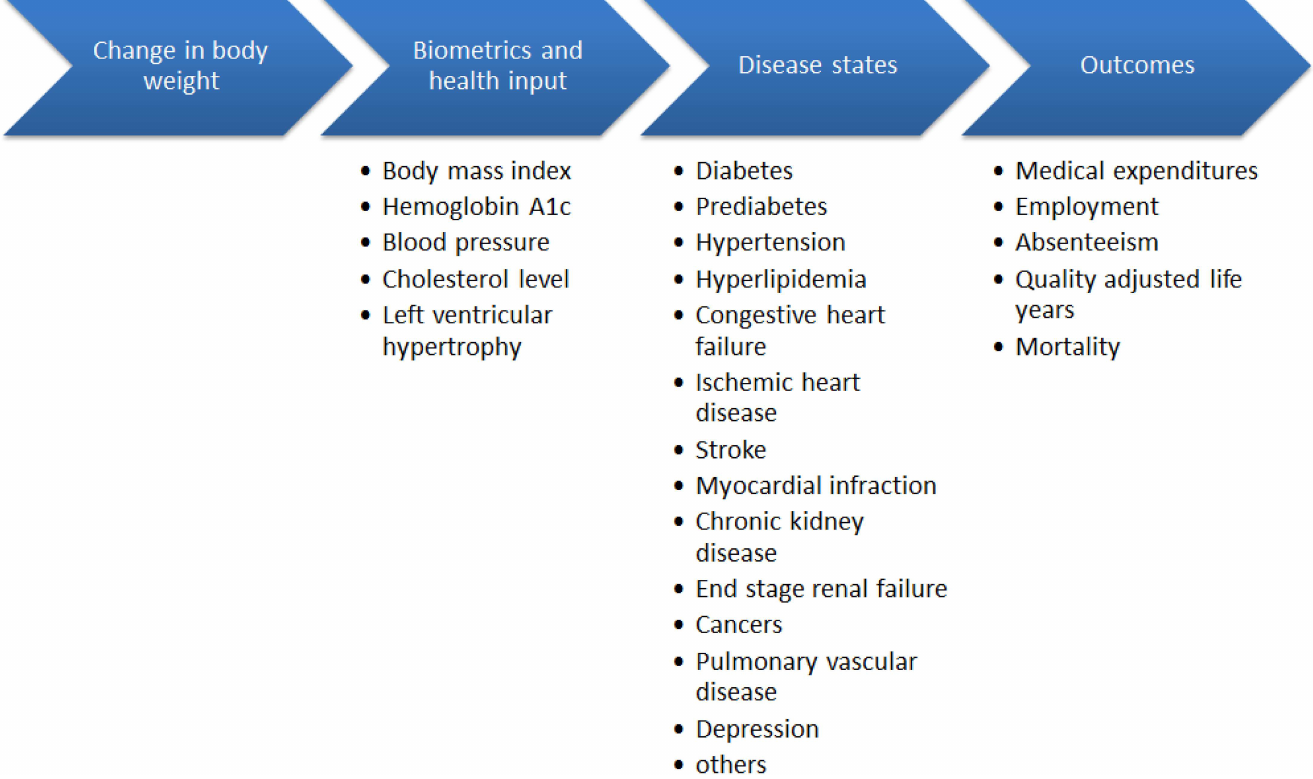
Fig 1. Model Overview